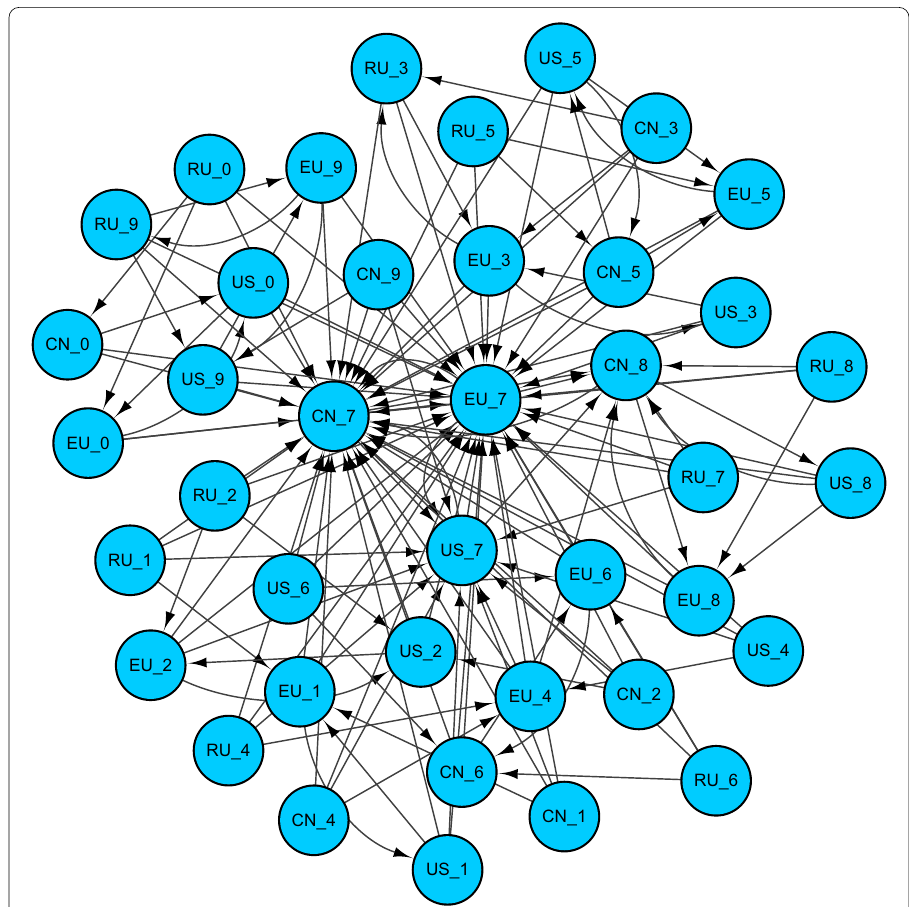
Fig. 9 Network trade structure. Same in Fig. 8 but for the reduced Google matrix G ∗ R corresponding of inverted trade flows (CheiRank or Export direction). The arrow direction from node A to node B means that B exports to